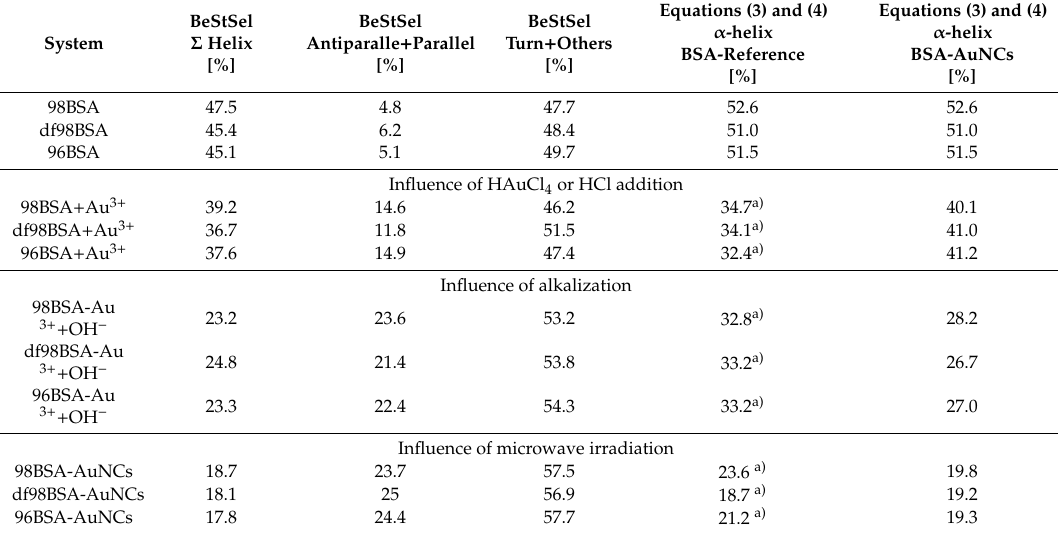
Table 1. Calculated α -helix content in albumin either by using BeStSel program (detailed structural changes shown in Table S1 (Supporting information)), or MRE values as in [11,39]. The changes of α -helix content in the course of AuNCs synthetic procedure and data for each type of BSA used in our study are